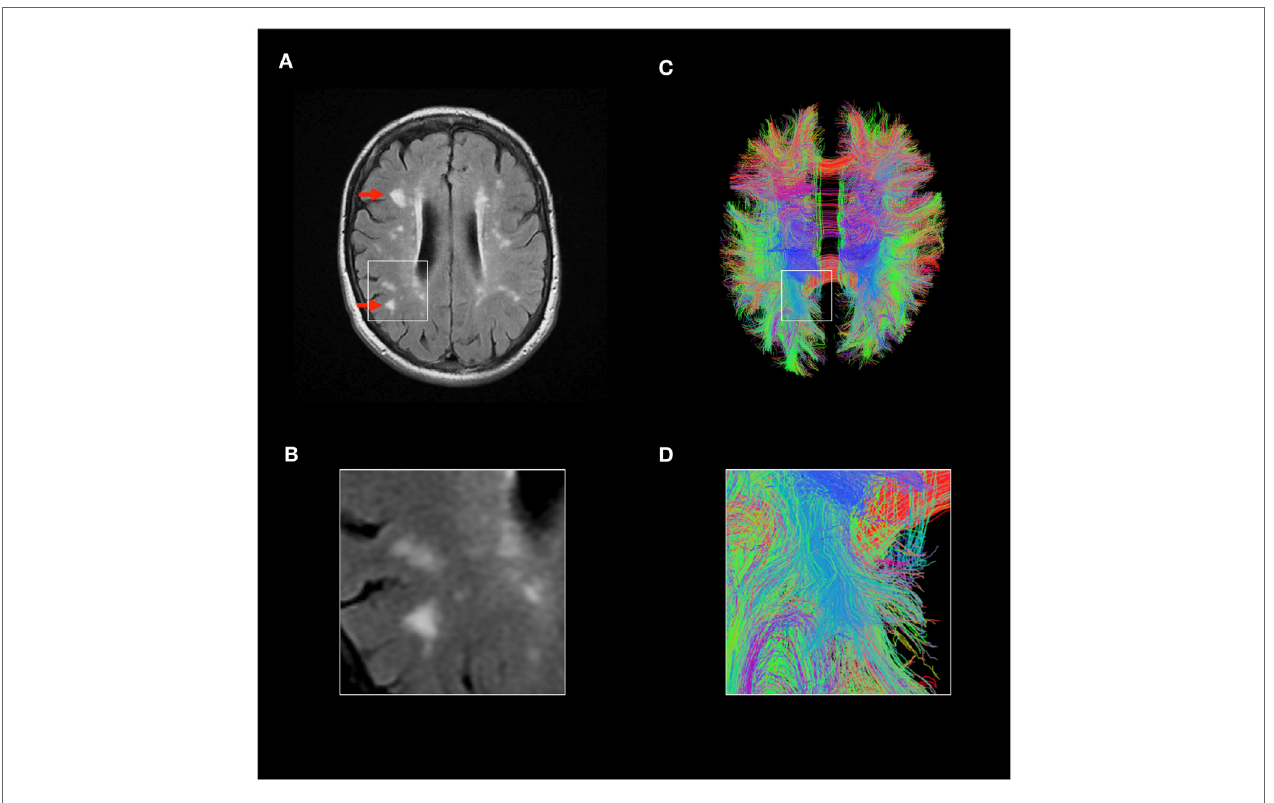
FigURe 3 | Magnetic resonance imaging (MRI) imaging in lupus brain disease. (A,b) Fluid-attenuated inversion recovery MRI scan of a representative individual with lupus, showing accelerated cerebral small vessel disease, highlighted red arrows. (C,D) Advanced MRI techniques such as diffusion tensor imaging and tractography can allow identification of individual white matter tracts and parameters such as mean diffusivity can identify microstructural disease. Tractography images of lupus patient shown, each line represents individual white matter tract. Credit: Mark Bastin, Joanna Wardlaw, and Stewart